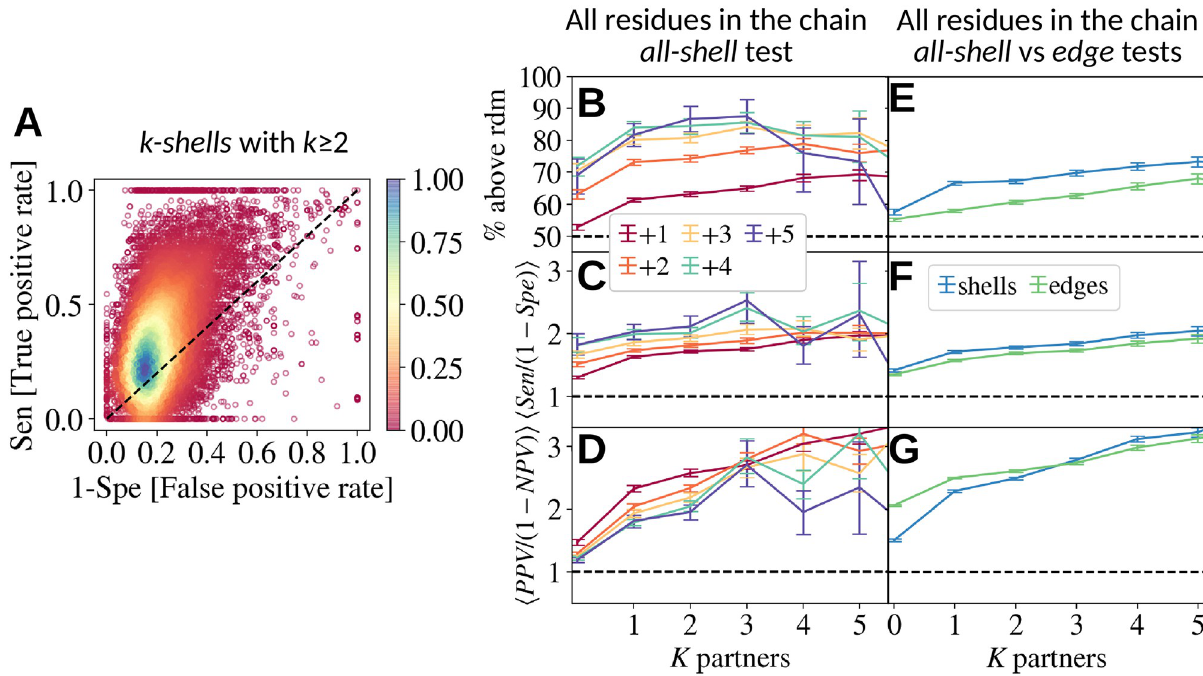
Fig 2. A. Analysis of all the predictions of the IRs evaluated in k - shell tests (for k � 2) for the entire set of clusters in our database. Each point in the plot reports sensitivity (Sen) versus 1-specificity (Spe) and corresponds to a prediction for a parent node. The color encodes the local density of that region. Random guesses should lie on the diagonal line. In this case, 75% of the predictions lie above this line. B. Percentage of predictions with Sen > 1-Spe conditioned to shells with at least + k new partners (in different colours) and parents with K neighbors. C,D. Same analysis as in B but for the ratios Sen/(1-Spe) and PPV/(1-NPV), respectively. E, F, G. Comparison of the all-shell statistics from previous panels with the analogous statistics extracted from the tests on the edges . In all cases, the horizontal line marks the random